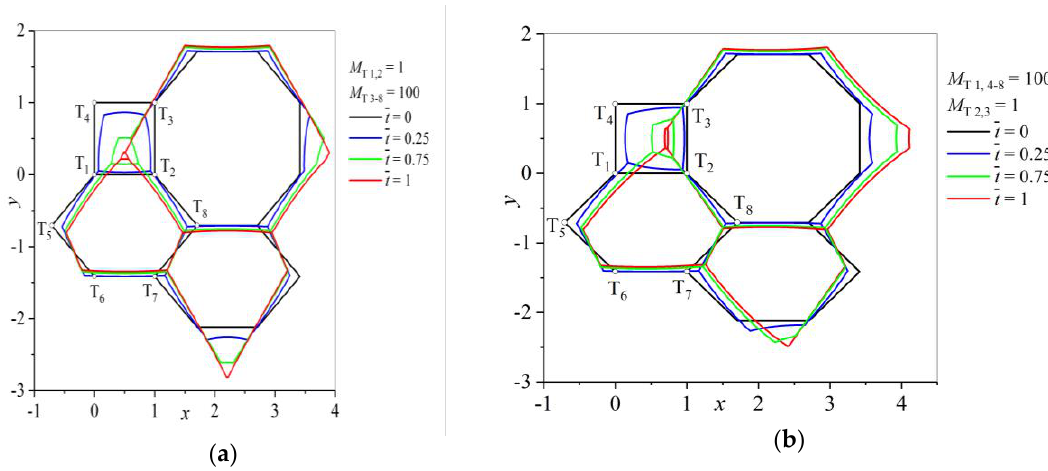
Figure 8. Evolution of the grain arrangement for different normalized times t . (a) Case V: The mobilities